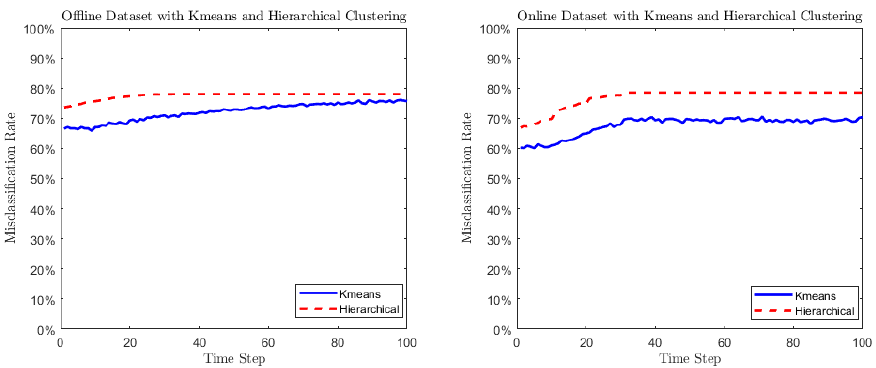
Figure 4. The functional form of H ( • ) follows Equation (73): H ( t ) = 0.5 + h i · t /100 with t = 0,1, . . . ,100. The left graph plots the misclassification rates output by K -means and hierar- chical clustering methods using the offline dataset. The right graph shows the misclassification rates using the online dataset.